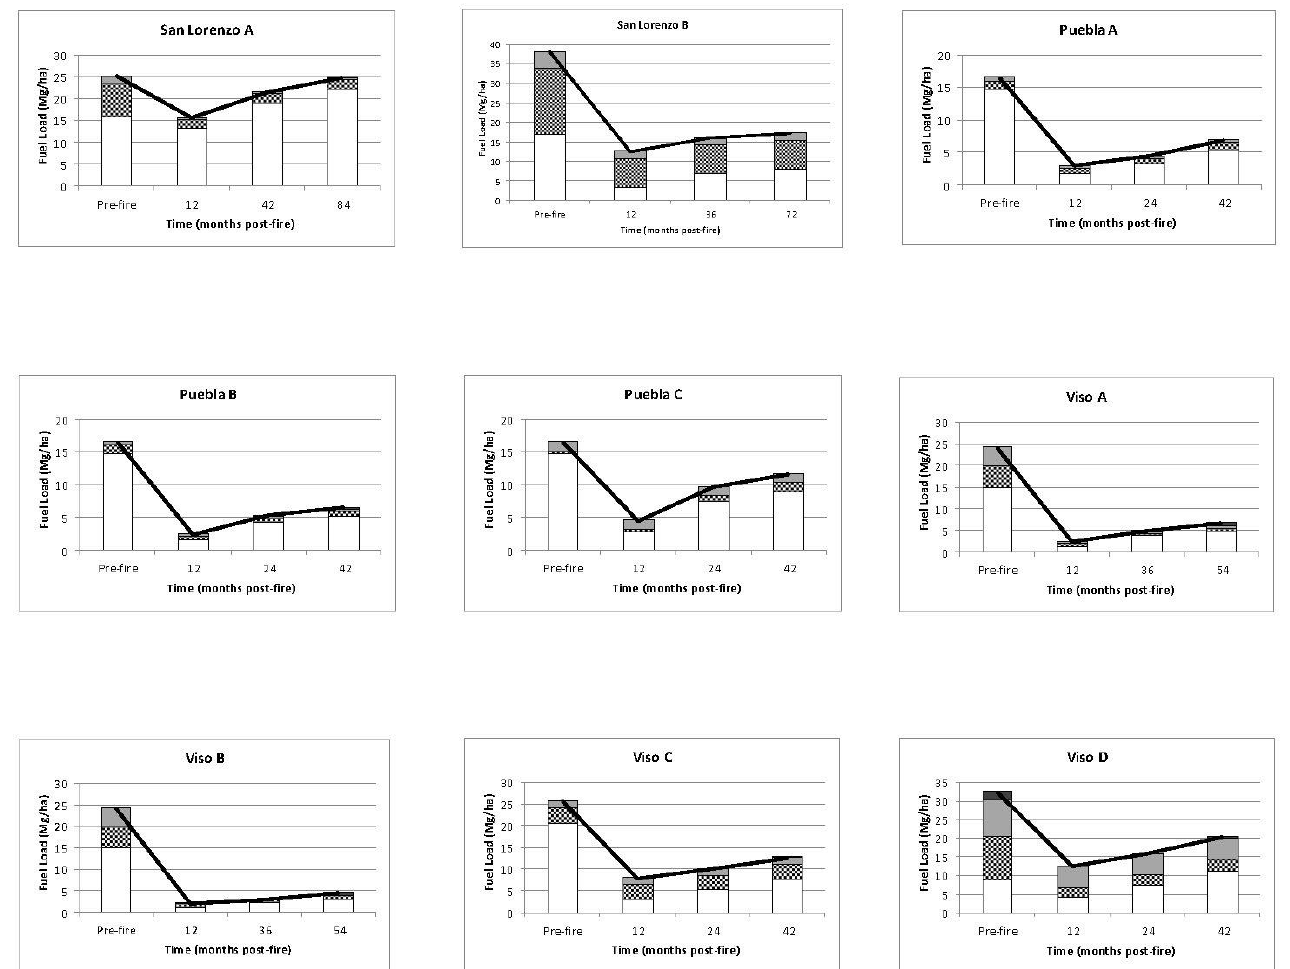
Figure 2. Temporal dynamics of the fuel load by categories in each stand.